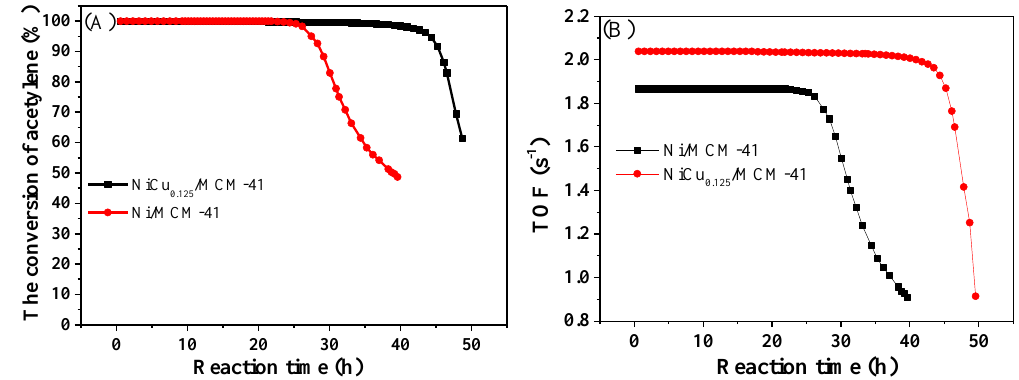
Figure 8. Catalytic stability ( A ) and the average turnover frequency ( B ) of the Ni/MCM-41 and NiCu 0.125 /MCM-41 catalysts at 250 °C and 8000 mL·g −1· h −1 .